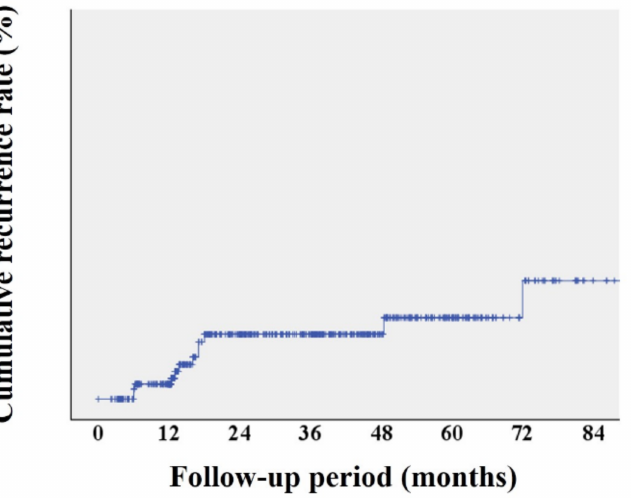
Figure 2. Overall cumulative recurrence after colorectal endoscopic submucosal